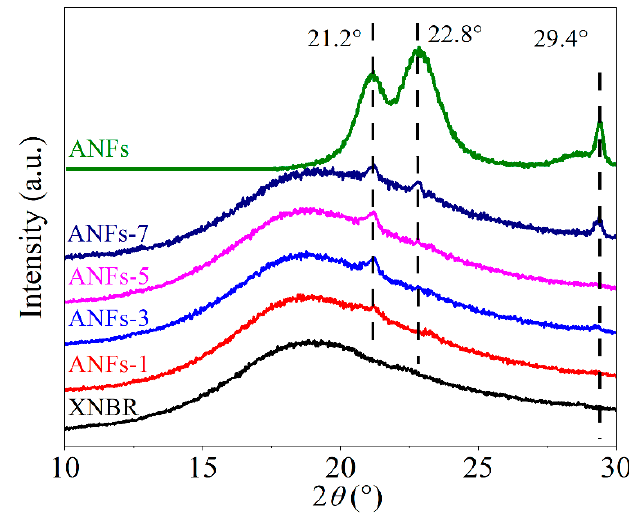
Figure 3. XRD patterns of ANFs and ANF/XNBR nanocomposites.